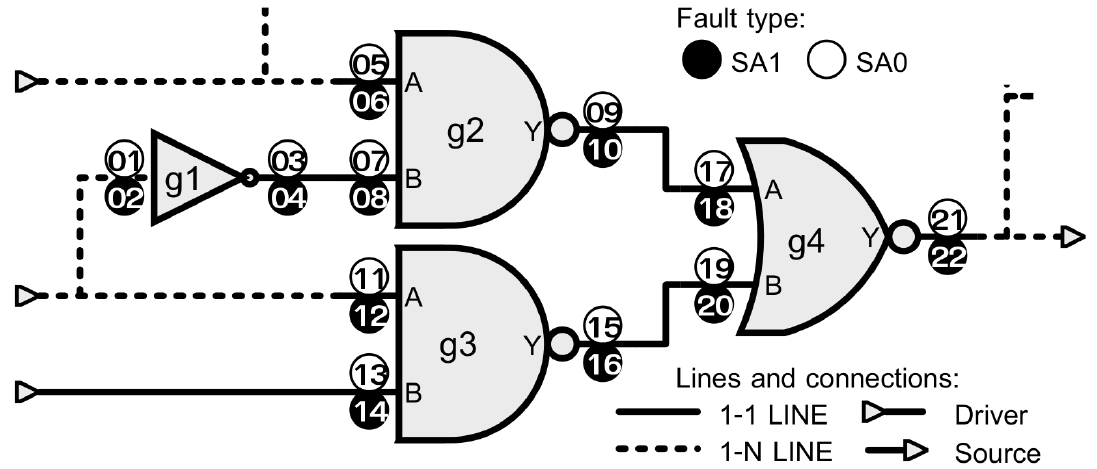
Figure 3. SAT fault